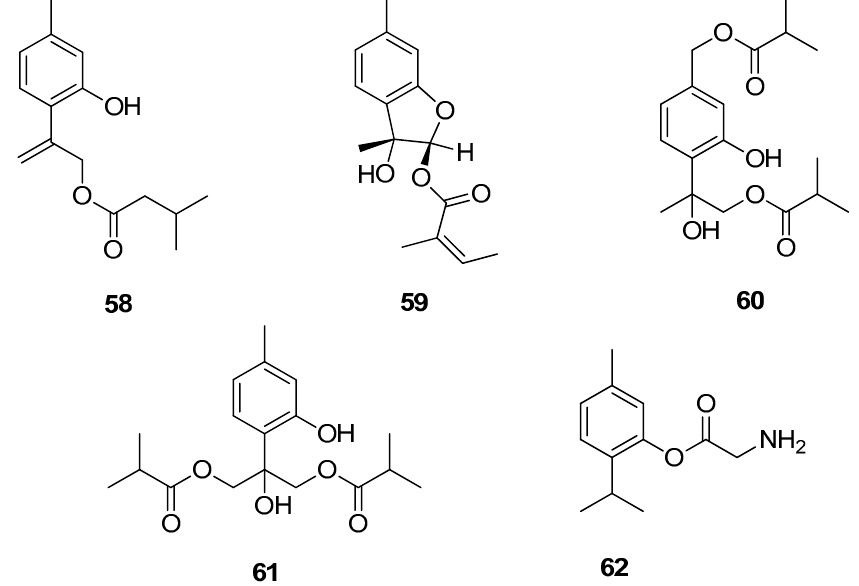
Figure 13. Thymol derivatives with anti-inflammatory activity.